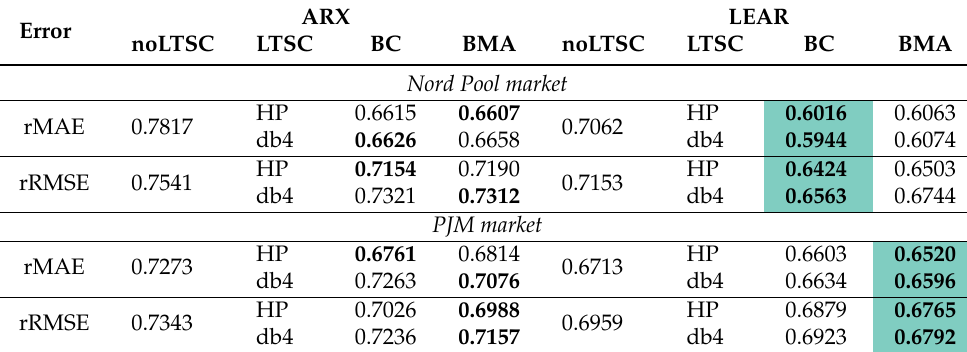
Table 3. The relative mean absolute errors (rMAE) and relative root mean squared errors (rRMSE) calculated in the model evaluation window for the combined and the baseline ARX and LEAR models. The lowest score in a row is emphasized in bold, independently for the ARX and LEAR models, whereas the lowest score in a row across all of the models has a green background. ARX LEAR Error noLTSC LTSC BC